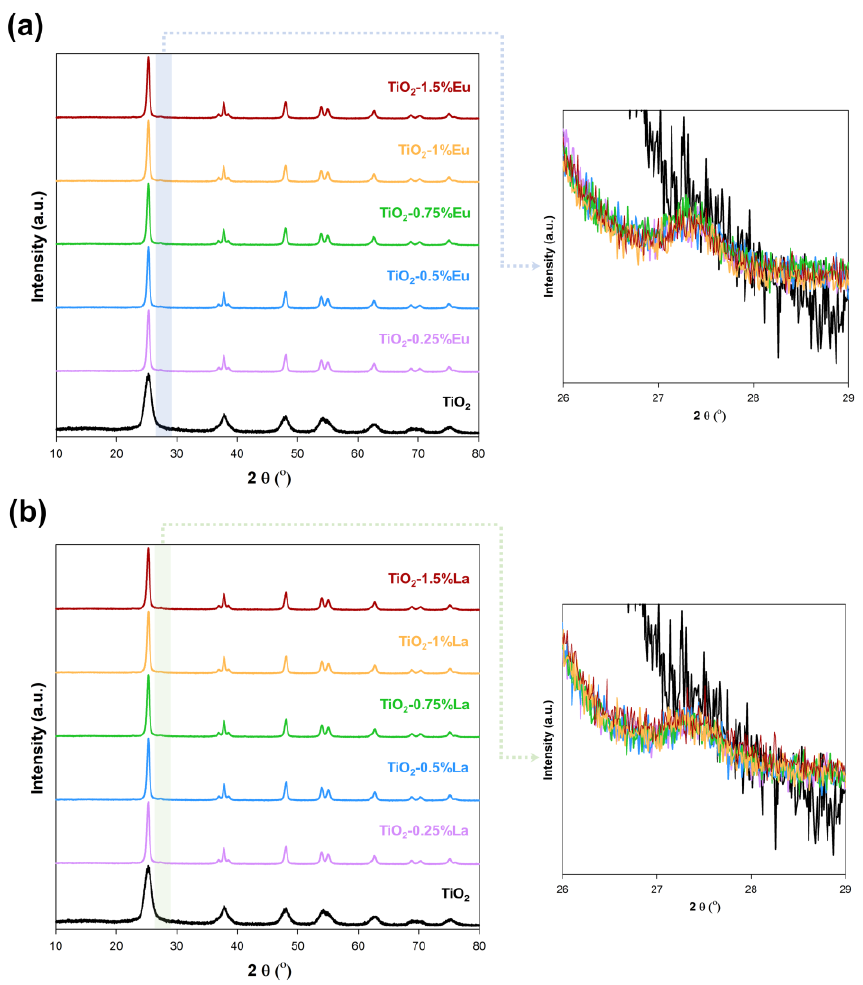
Figure 1. The XRD patterns for ( a ) TiO 2 -Eu and ( b ) TiO 2 -La systems. Regardless of the analyzed system, modification with europium or lanthanum, two crystal structures were noted for the obtained samples, anatase and rutile (space group P4 2 /mnm , no. 136). The absence of characteristic peaks from europium and lanthanum on